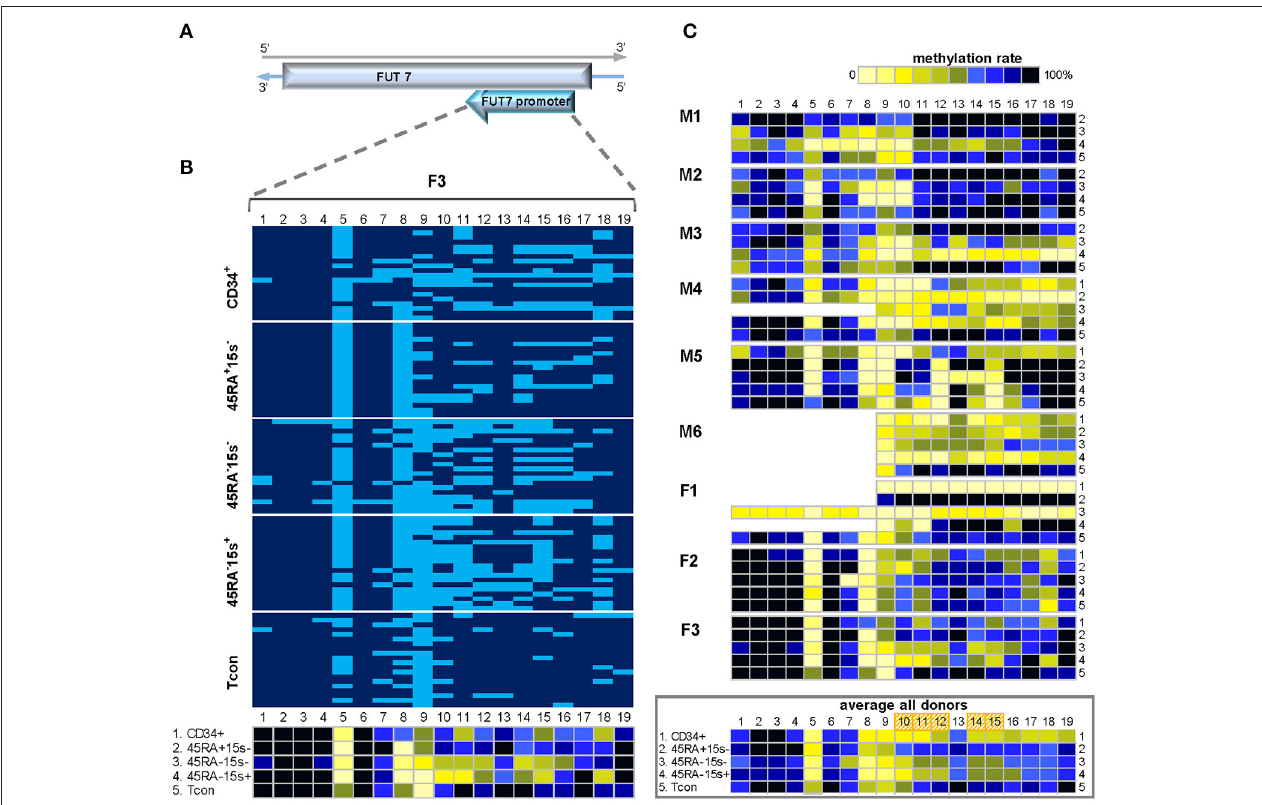
FIGURE 3 | Methylation pattern of FUT7 promoter. CpG sites 10–12, 14, and 15 within FUT7 promoter display higher demethylation levels in CD34 + and effector Treg as compared to naïve Treg and Tcon, indicating that CpGs 10-15 can be used as an additional molecular marker to distinguish these cell populations. (A) Schematic presentation of FUT7 promoter encoded in the reverse strand of chromosome 9. (B) Methylation pattern of FUT7 promoter in five cell populations: CD34 + (1), CD45RA + CD15s − (2), CD45RA − CD15s − (3), CD45RA − CD15s + (4), and Tcon (5) of representative donor F3. CpGs 1-19 are numbered relative to the 5 ′ -3 ′ direction of the coding (reverse) strand. Each horizontal line represents DNA from one cell with unmodified C in light blue and m C in dark blue. Methylation percentage for each CpG site was calculated based on the number of m Cs in a total of 20 and summarized in the panel below. (C) Methylation patterns of FUT7 promoter of individual donors with the average methylation pattern for all donors presented in the panel below. See also Supplementary Figures 1 , 3